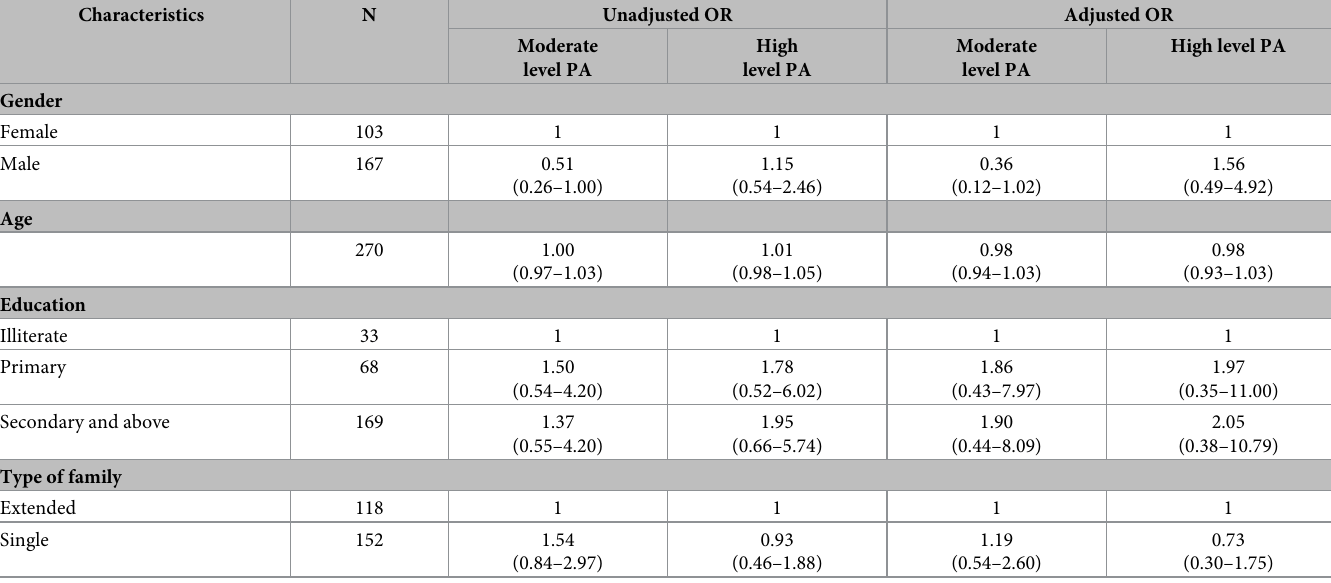
Table 4. Multinomial logistic regression analysis of high and moderate level physical activity among urban diabetic patients in Nepal (n = 270).